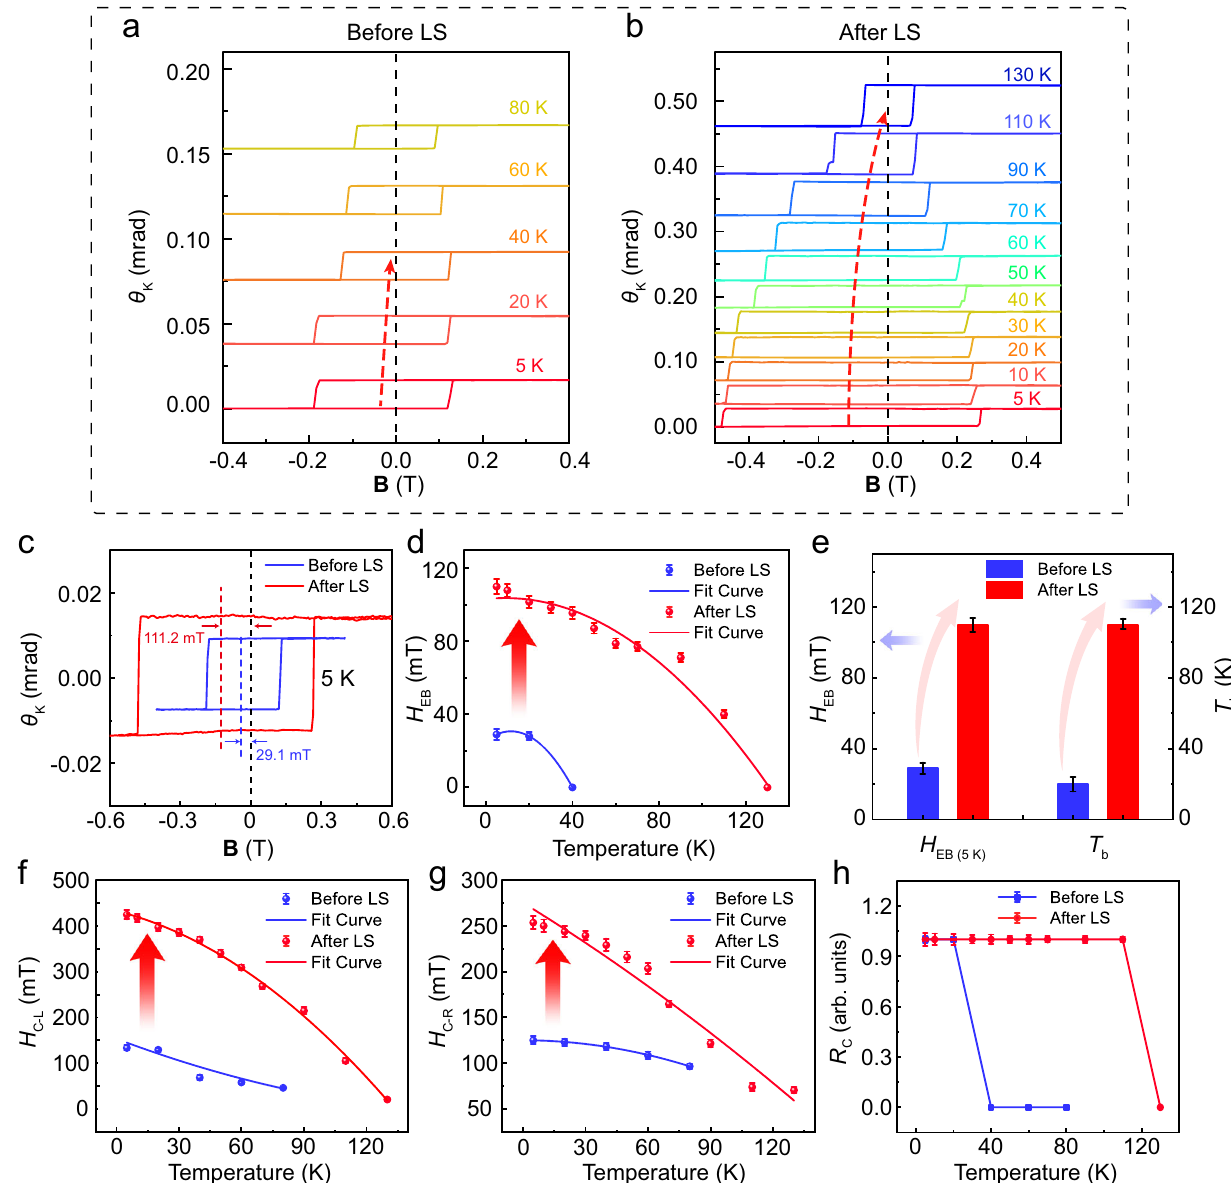
Fig. 2 | Enhanced EB effect through LS. a , b The temperature-dependent Kerr loops of FPSe/FGT heterostructures before and after LS. c Kerr loops versus the magnetic fi eld for FPSe/FGT heterostructure through the magneto-optical Kerr test before and after LS at 5K. d A detailed comparative investigation for H EB and T b versus the temperature before and after LS at 5K. e Summary of